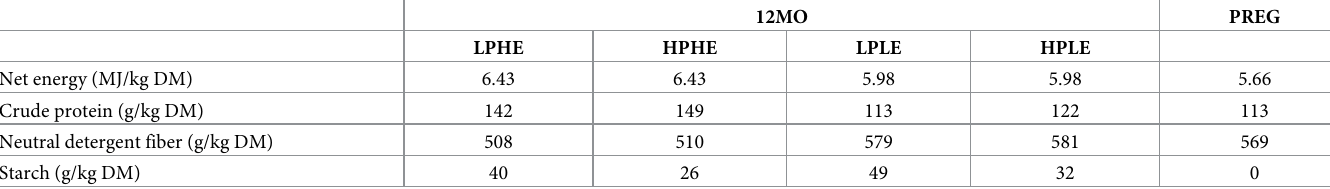
Experimental diets were Low-protein, High-energy (LPHE), High-protein, High-energy (HPHE), Low-protein, Low-energy (LPLE) and High-protein, Low-energy (HPLE). PREG = Pregnancy diet given to all animals. Total ration content for 12MO diets was calculated in Optifoˆr, a digital feed planning tool based on NorFoˆr, the Nordic feed evaluation system for cattle [33]. Input data were the nutrient content of the roughages and concentrates used and least square means of roughage and concentrate intake at 12 months for each treatment. Total ration content for the PREG diet was calculated as the average nutrient content of the roughages offered during